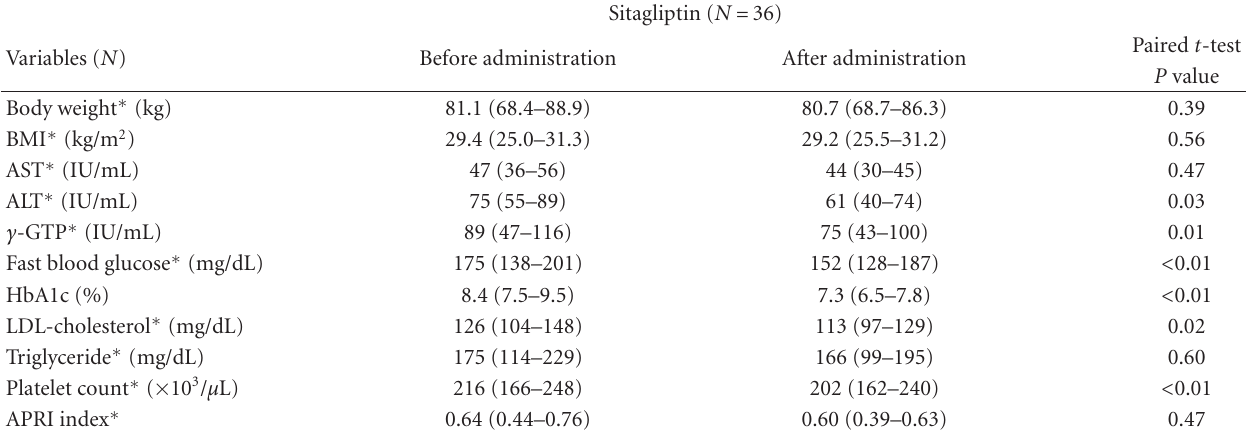
Table 3: Change of parameters after administration of sitagliptin.